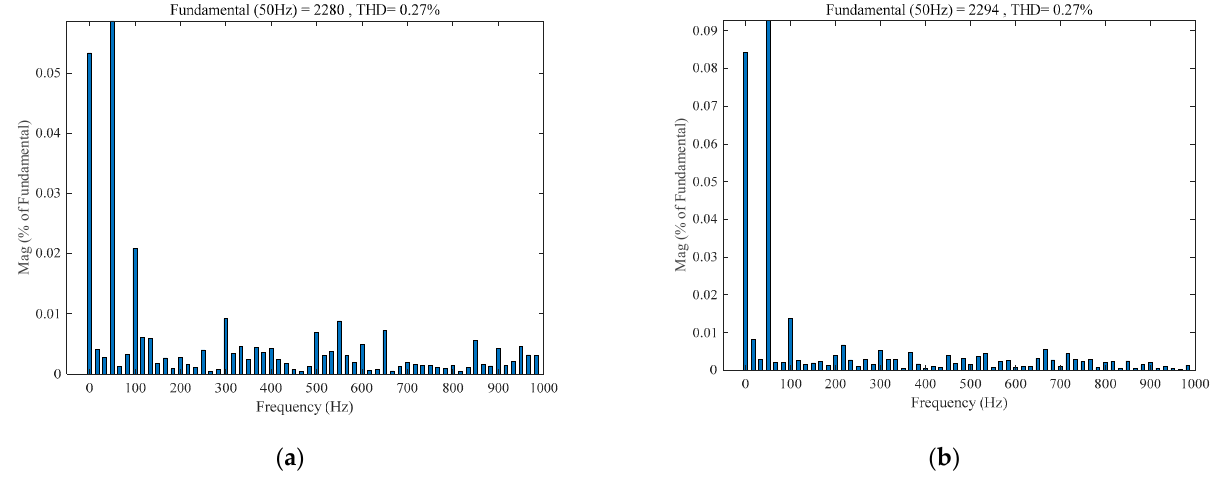
Figure 6. Output current fast Fourier transform (FFT) analysis. ( a ) Traditional predictive current control (PCC); ( b ) Improved SMPCC.